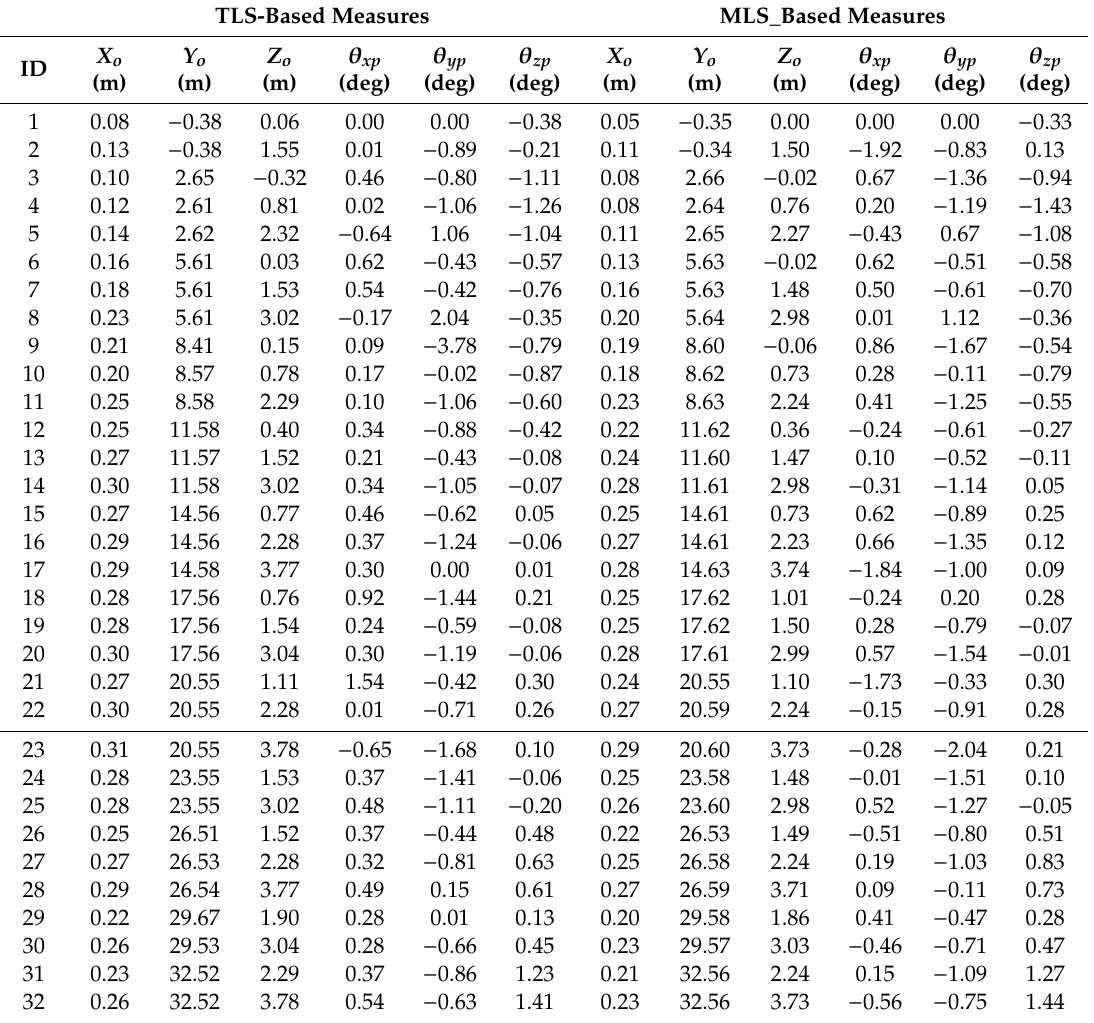
Table 6. TLS-based and MLS-based panel parametrization for the textured MSE wall at Site-1. TLS-Based Measures MLS_Based